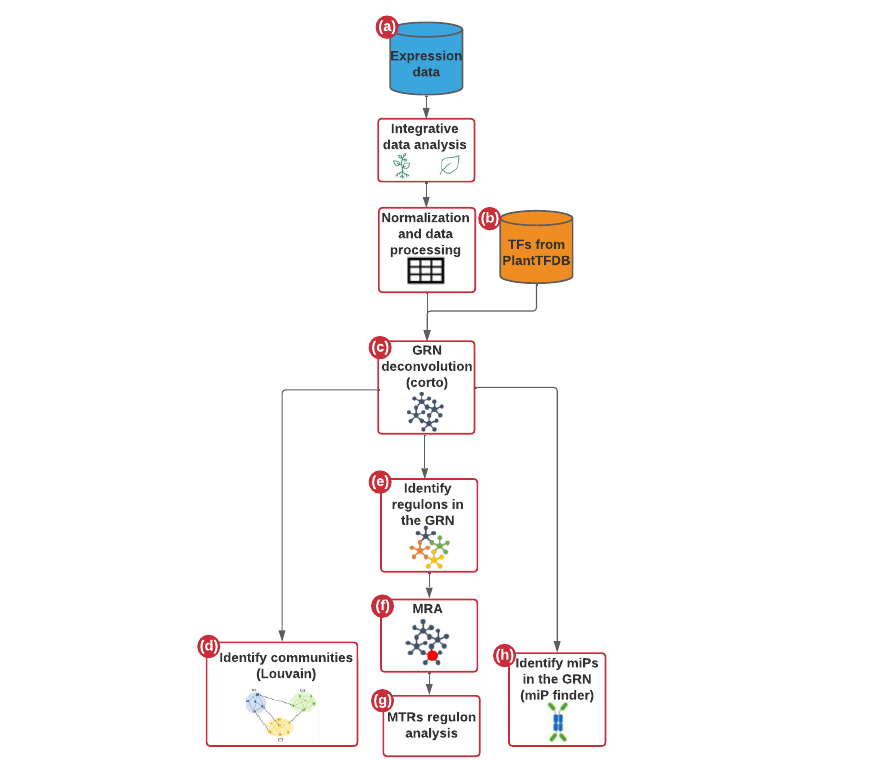
Figure 1. Pipeline for the omics approach. ( a ) First, microarray publicly available expression data of both control and infected leaves and roots were processed to obtain a unique expression matrix ( b ) The expression matrix and a list of tomato genome transcription factors from PlantTFD were used as input to ( c ) infer a network of transcriptional regulation employing Corto algorithm. ( d ) Then, biological communities were found in the network clustering genes by their metrics using the Louvain algorithm. From the obtained GRN ( e ) a regulon network was obtained by associating the expression level of the targets of all the transcription factors ( f ) Subsequently, the MRA algorithm was used to calculate the MTRs in the network ( g ) Once the MTRs are inferred we proceed to explore the functional role of them and their regulons. ( h ) Additionally, the bHLH-coding genes for miPs were assigned in the tomato genome. Among them, we identify those that are interacting in the GRN, and those that could be potential MTRs.